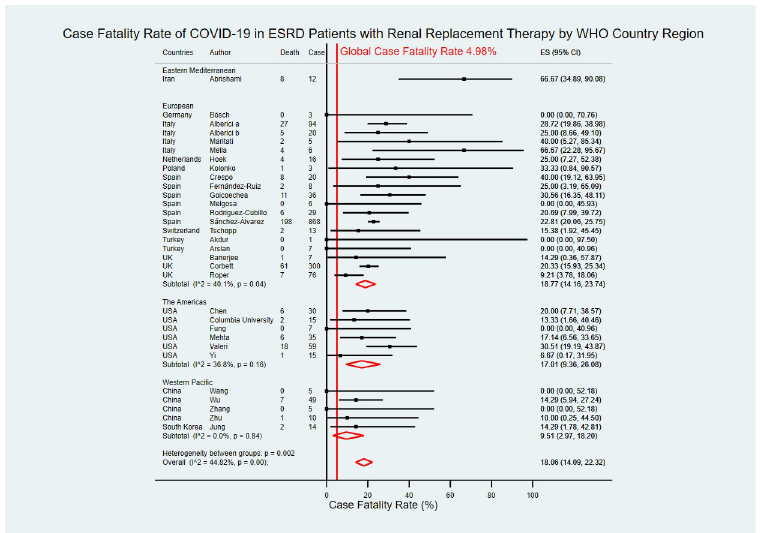
Fig 8. Forest plot of the case fatality rate of COVID-19 in ESRD patients with RRT by WHO country region. The figure summarizes the number of COVID-19 deaths in ESRD patients with RRT and the number of COVID-19 confirmed cases in ESRD patients with RRT in 31 eligible studies with subgroup analysis by WHO country regions. The forest plot represents the estimated case fatality rate of COVID-19 in ESRD patients with RRT for each study (black boxes), with 95% confidence intervals (95% CI; horizontal black lines). The estimated pooled case fatality rate for each subgroup was presented with a red diamond. The overall estimated pooled case fatality rate (last red diamond) was 18.06% (95% CI 14.09–22.32). The global case fatality rate (vertical red line) was 4.98%. The meta-analysis used a random-effects model with the exact method for confidence interval estimation. ES, effect size. I 2 , test for